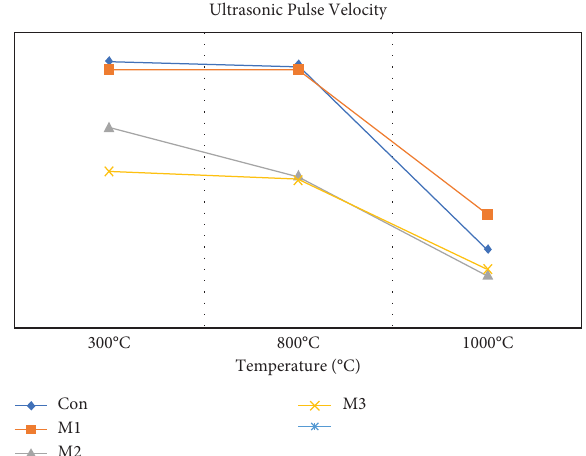
Figure 18: Ultrasonic pulse velocity test of postheated concrete cylinder samples.